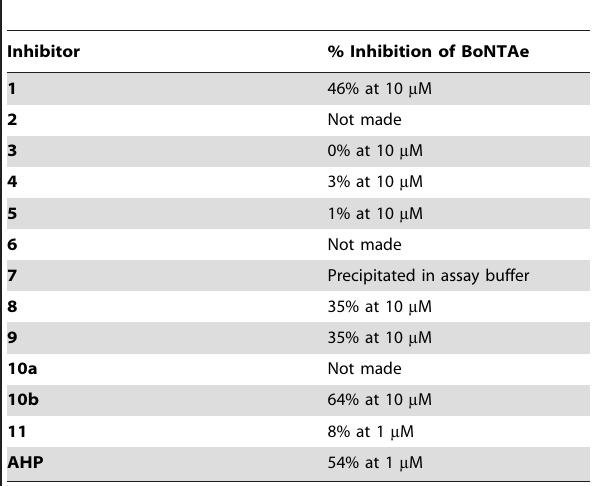
Table 1. Relative BoNTAe inhibition activities of AHP and its